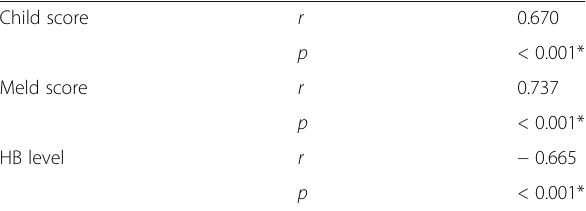
Table 5 Correlation between small-bowel findings and Child score, Meld score, and HB level